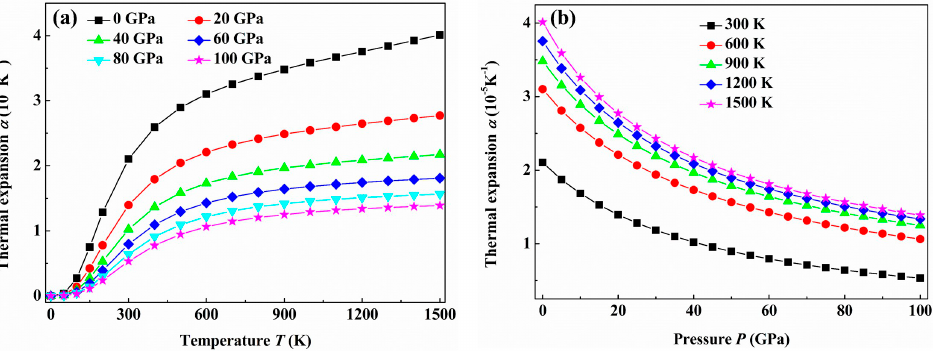
Figure 10. Temperature ( a ) and pressure ( b ) dependence of the thermal expansion coefficient α for the C 2/ m -ZrB 3 .